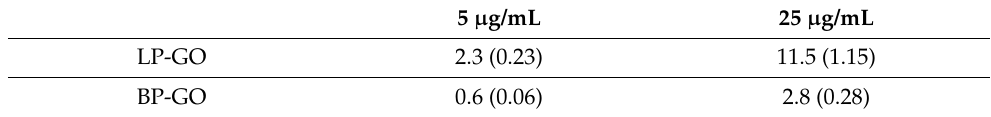
Table 3. Concentration of endotoxin in P-GO nanoparticles, EU/mL